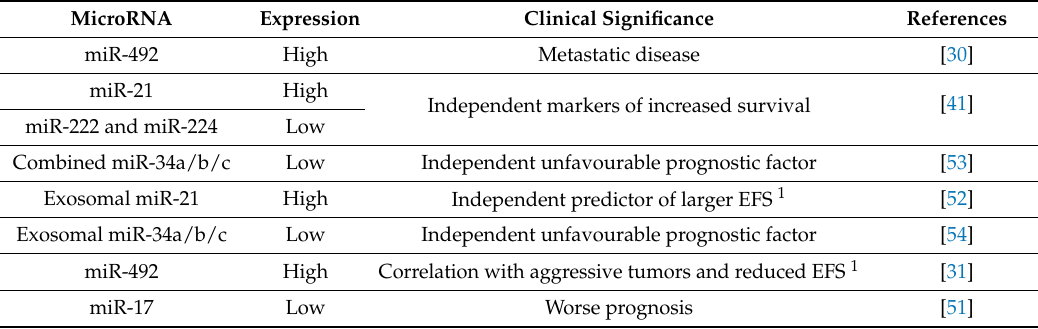
Table 2. MicroRNAs as prognostic markers in